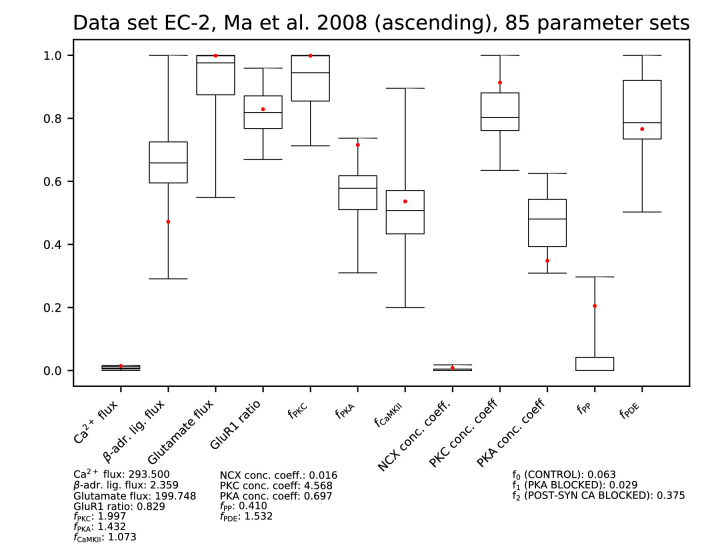
Parameters for data set EC-2.See Figure 9—figure supplement 1 for details.